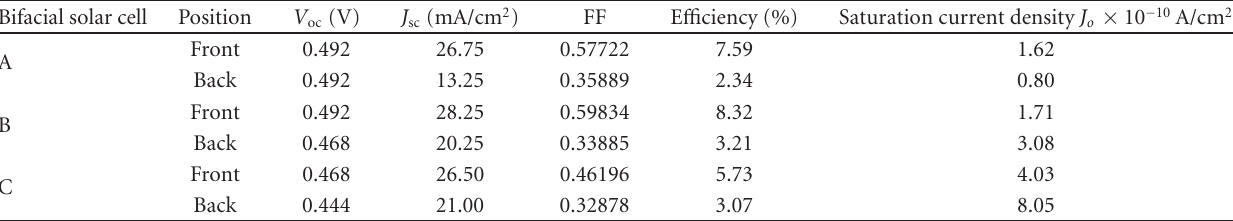
Figure 7: I - V curves for front and rear illumination of bifacial solar cell for SiO 2 , SiN, and SiO 2 /SiN stack ARC and passivation layers. Table 3: Measured IV results of bifacial solar